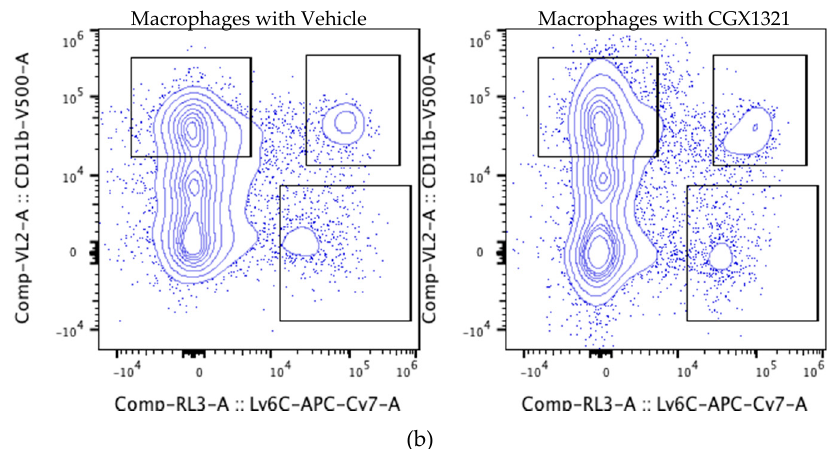
Figure 5. In vivo effect of Wnt signaling inhibition in omentum tumor and the microenvironment. ( a ) NanoString analysis of omentum at 42 days tumor challenge with ID8 cells showed an increase in gene signatures for T cell functions, macrophage functions, dendritic cell functions and antigen processing with CGX1321 treatment. ( b ) After 42 days of ID8 tumor challenge, flow cytometry of omentum tumor showed an increase in macrophages and DCs with CGX1321 treatment. Flow gating strategy is shown first for omentum tumor DCs with vehicle or CGX1321 treatment, and similarly for macrophages.